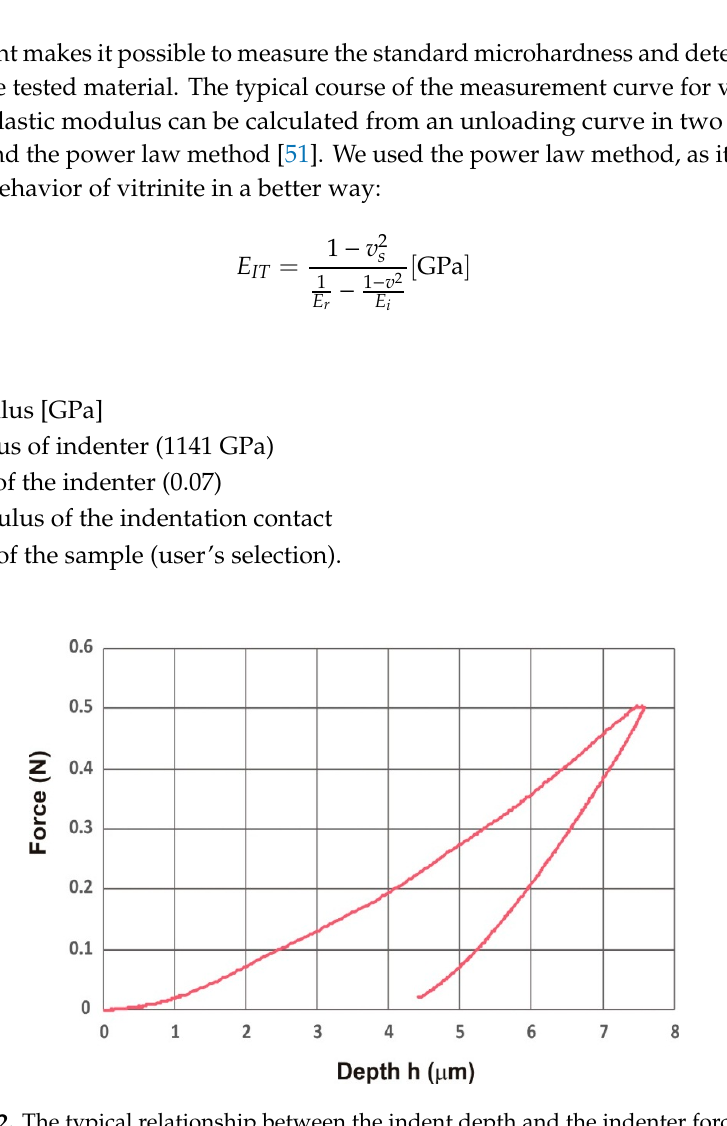
Figure 2. The typical relationship between the indent depth and the indenter force F IT .